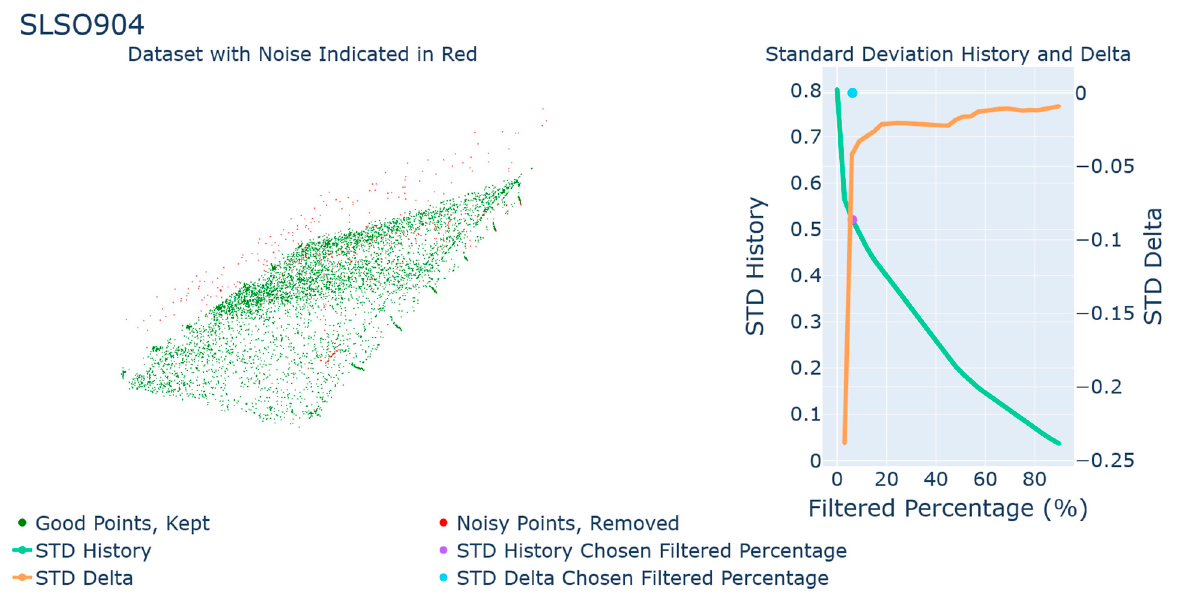
Figure 12. Results for the SLS part at − 10° after 90° rotation, overexposed.